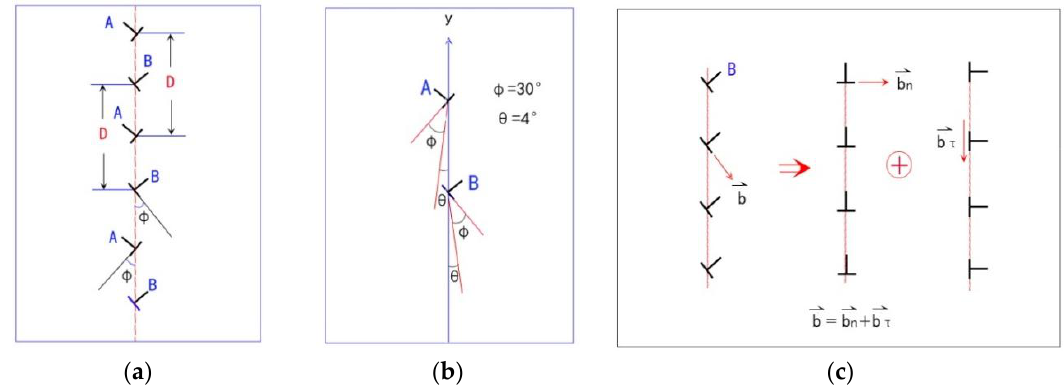
Figure 10. Schematic of GB dislocation: ( a ) Two type dislocations A and B arranging alternatively in the STGB, ( b ) Tilt angle θ of the STGB and atomic arrangement orientation Φ of the grain, ( c ) The dislocation → → b decomposition: one b n is the vertical to the GB, which forms a similar structure of the sessile vector extrinsic grain boundary dislocation (EGBD) [94] and leads to the GB migration and grain growth, → b τ is parallel to the GB, which forms a similar structure of the glissle EGBD and leads to and the other the dislocation motion along the GB and the grain orientation